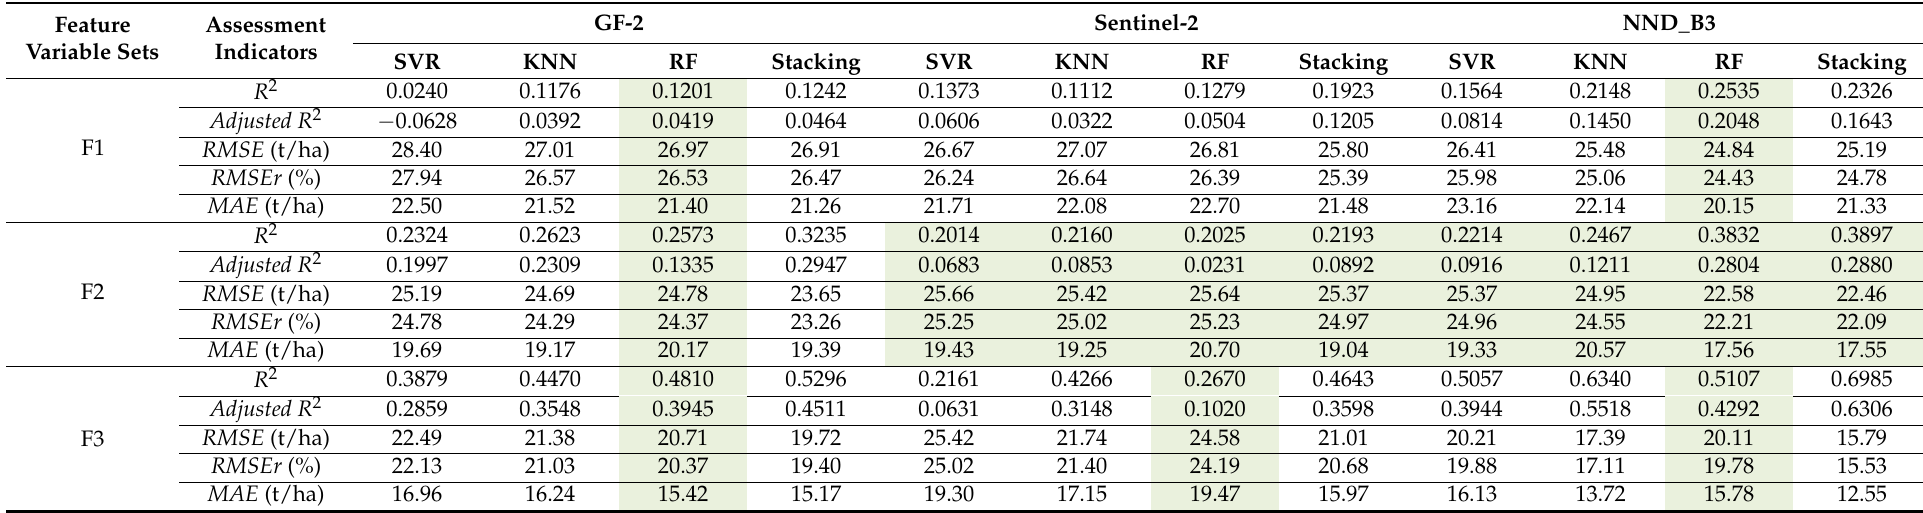
Table A1. The summary of assessment indicators for AGB estimation results of Chinese fir plantations based on nine image feature data scenarios and four estimation algorithms. The estimation results are the better ones of the feature screened by the KNN-based and RFR-based algorithms. The data scene with light green shade in the table indicates that the estimation result of feature variables selected by the RFR-based algorithm is better than the KNN-based method. However, the KNN-based algorithm is better in other data